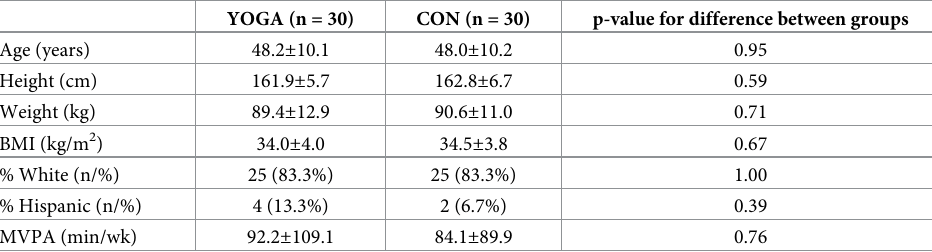
Table 3. Baseline characteristics by intervention